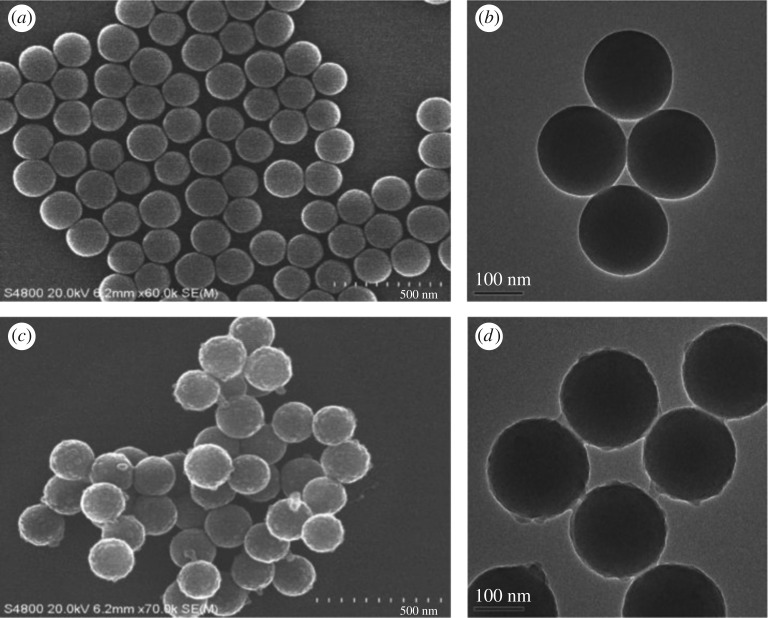
SEM and TEM images of SiO2 (a,b) and SiO2@ANA-Si (c,d).